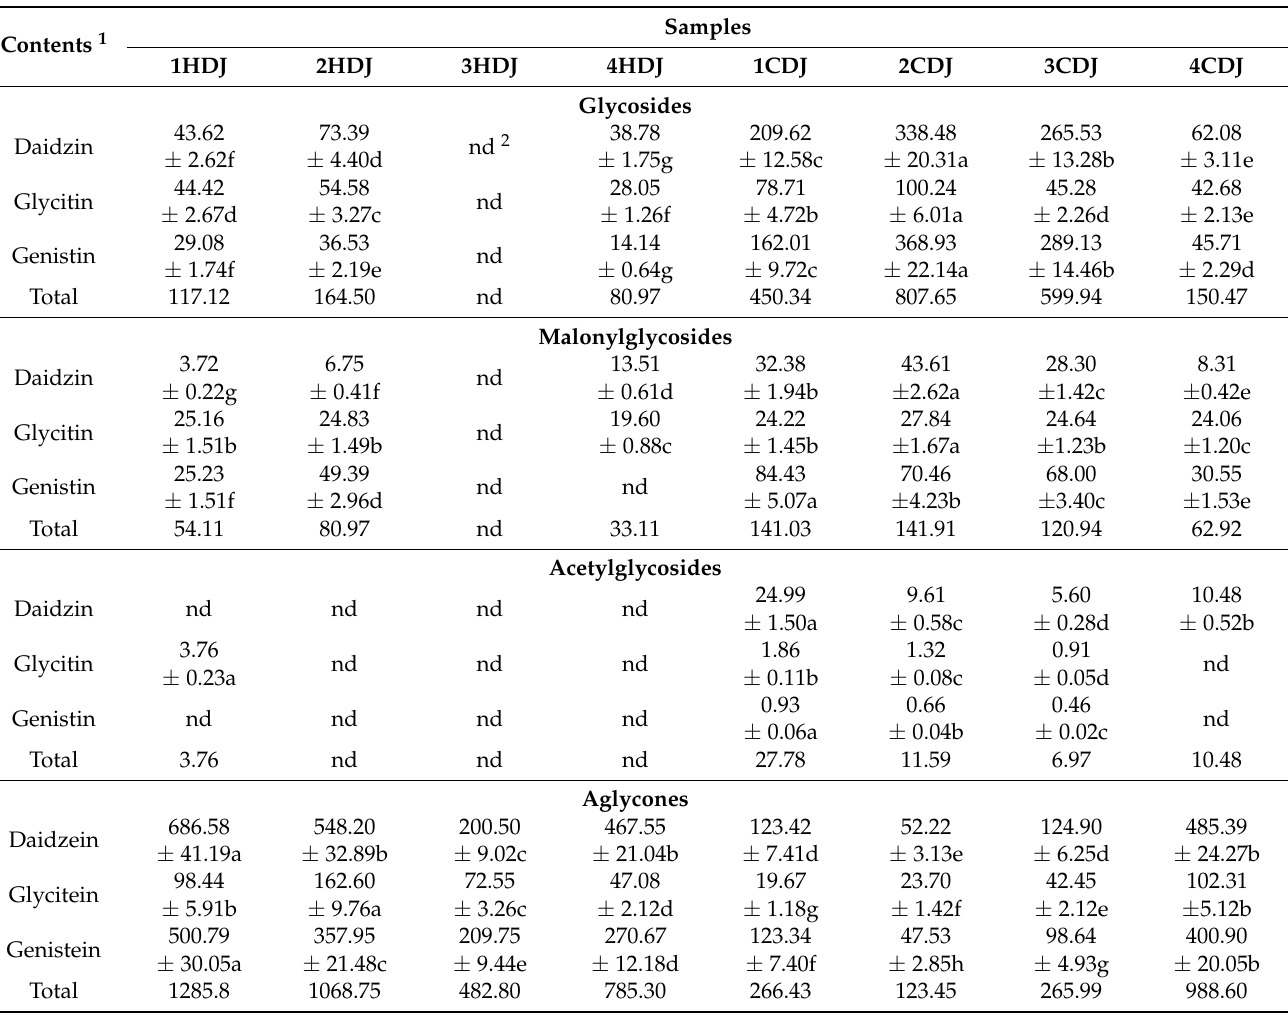
Table 3. Comparison of glycoside, malonylglycoside, acetylglycoside, and aglycone isoflavone contents on household and commercial doenjang